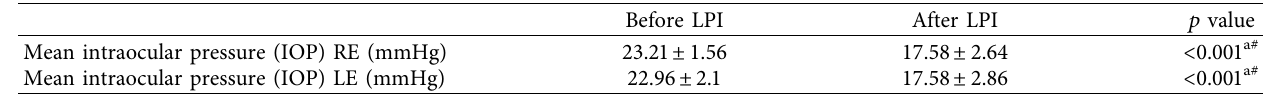
Table 2: Values of intraocular pressure (IOP) before and after laser peripheral iridotomy.